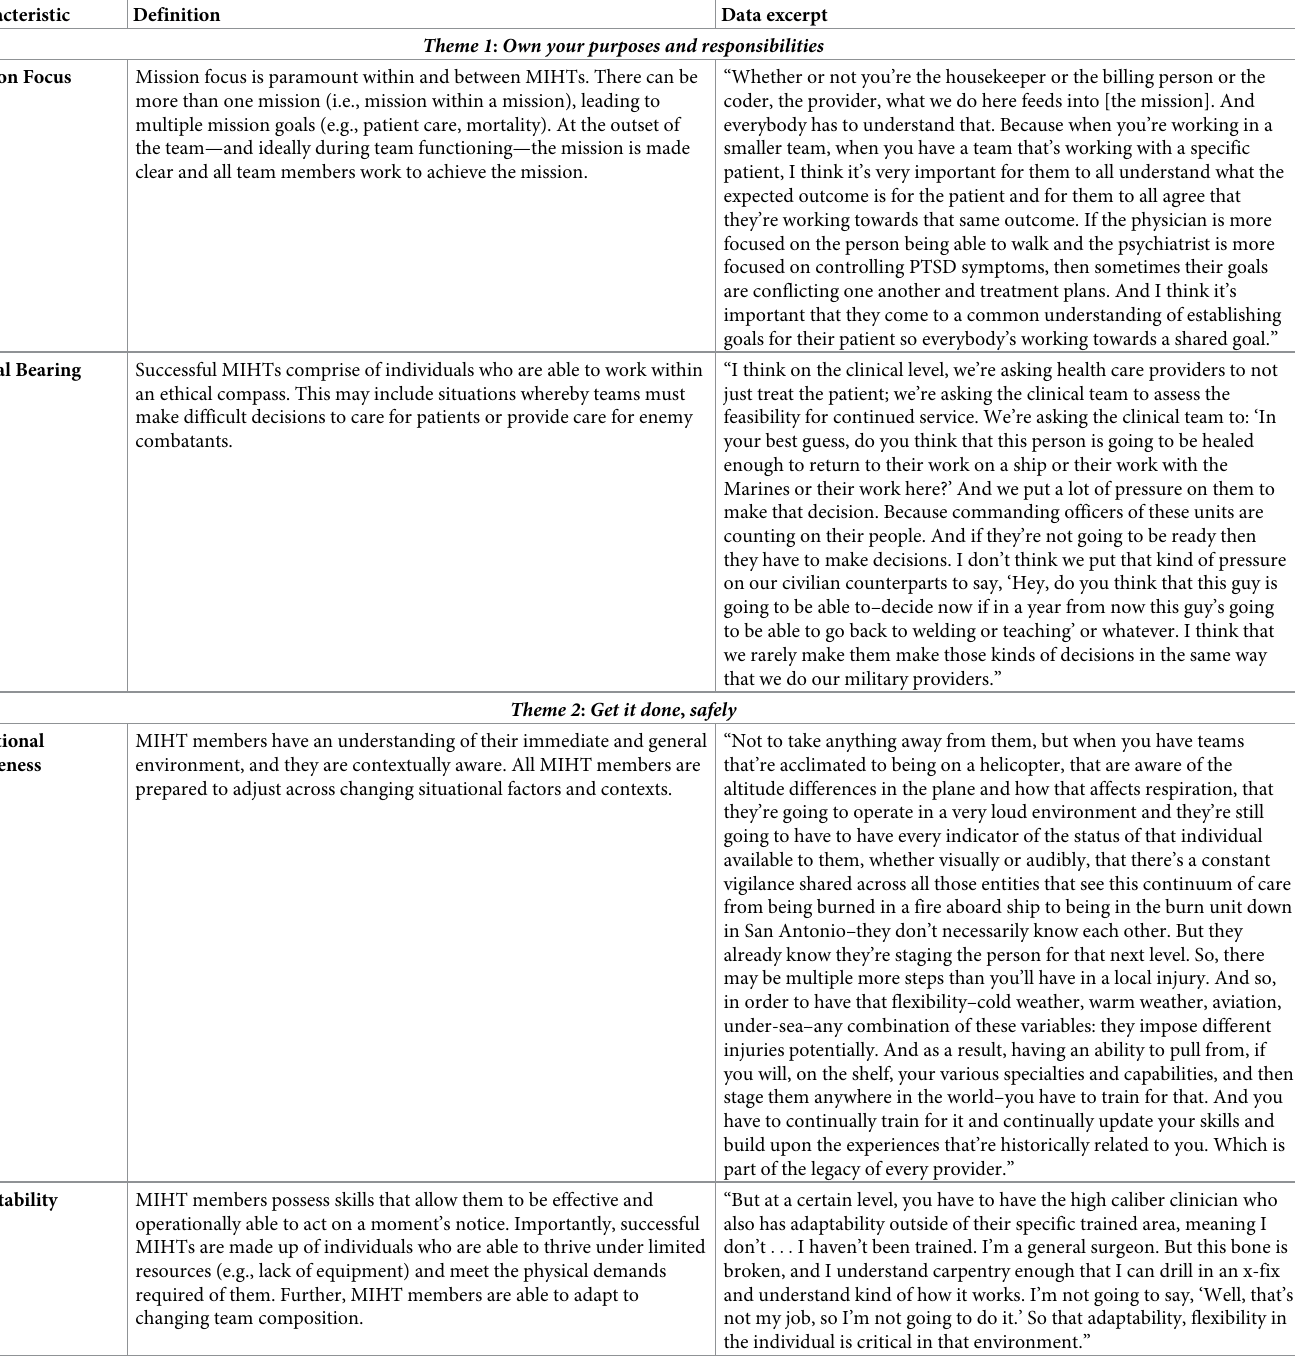
Table 3. Characteristics unique to